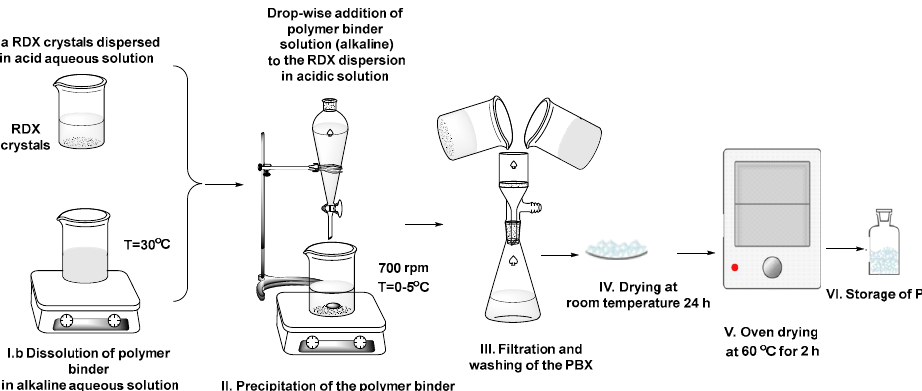
Figure 1. Schematic representation of the development process of PBX 1 and PBX 2